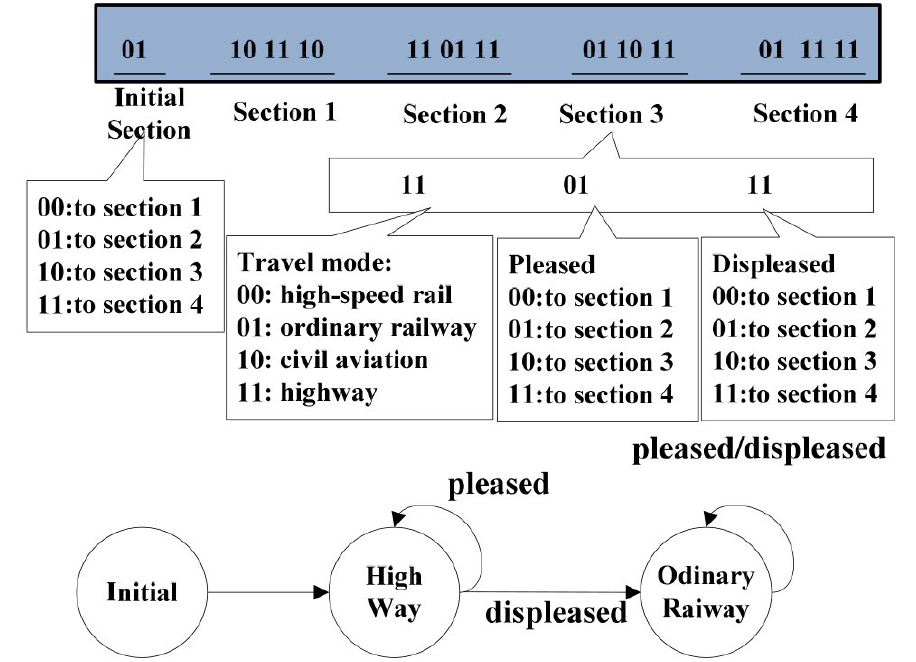
Figure 2. Act Decision-making Chain of Low-income